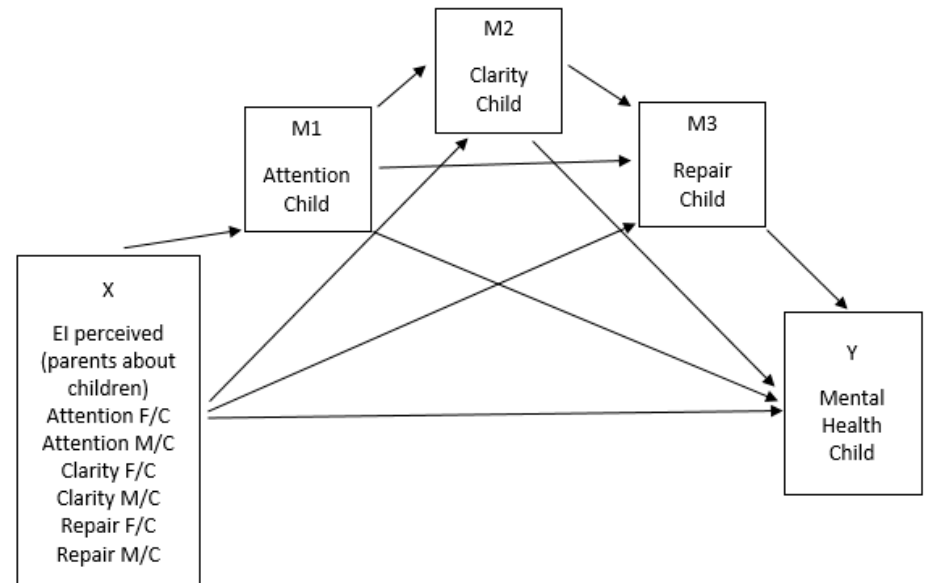
Figure 1. Hypothesized model (H1), (F/C = Fathers’ perceived emotional intelligence (EI) of their children; M/C = Mothers’ perceived of their children).